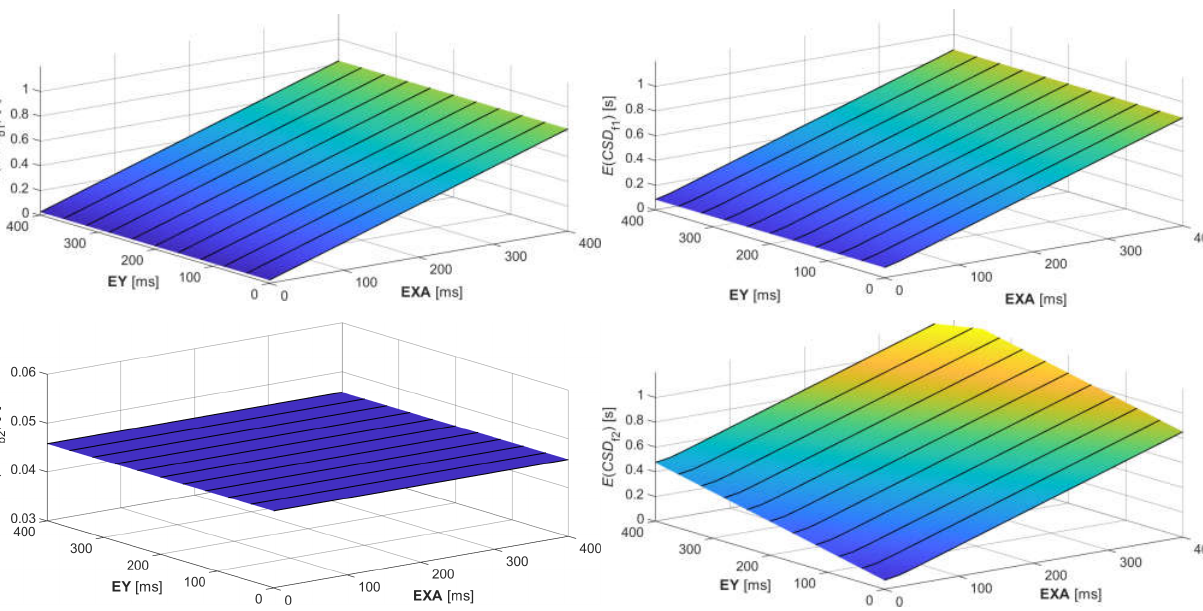
Figure 8. Selected results for data set 5 from Table 1.